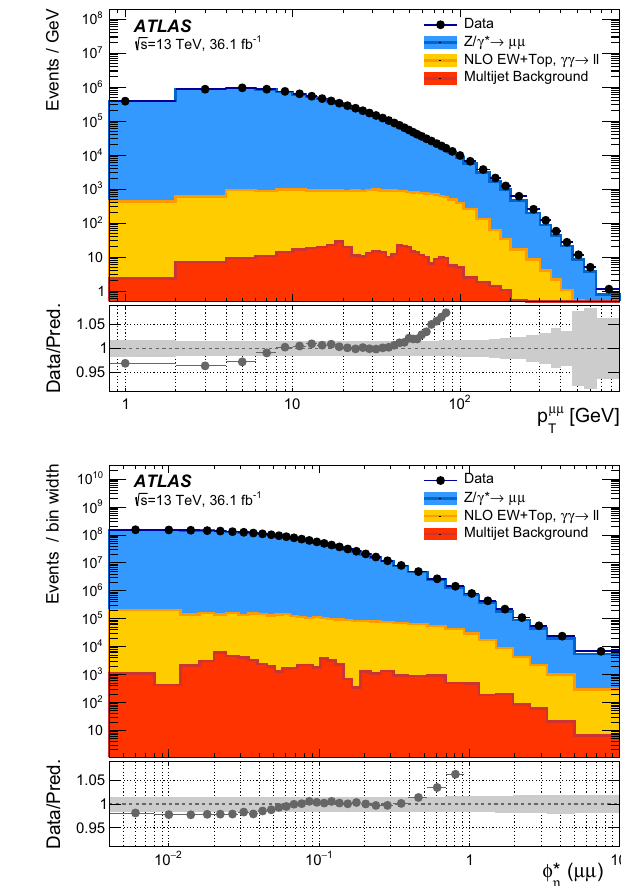
Fig. 2 The distribution of events passing the selection requirements in the electron channel (left) and muon channel (right) as a function of dilepton transverse momentum (upper row) and φ ∗ η (lower row). The MCsignalsampleissimulatedusing Powheg + Pythia 8.Thestatistical